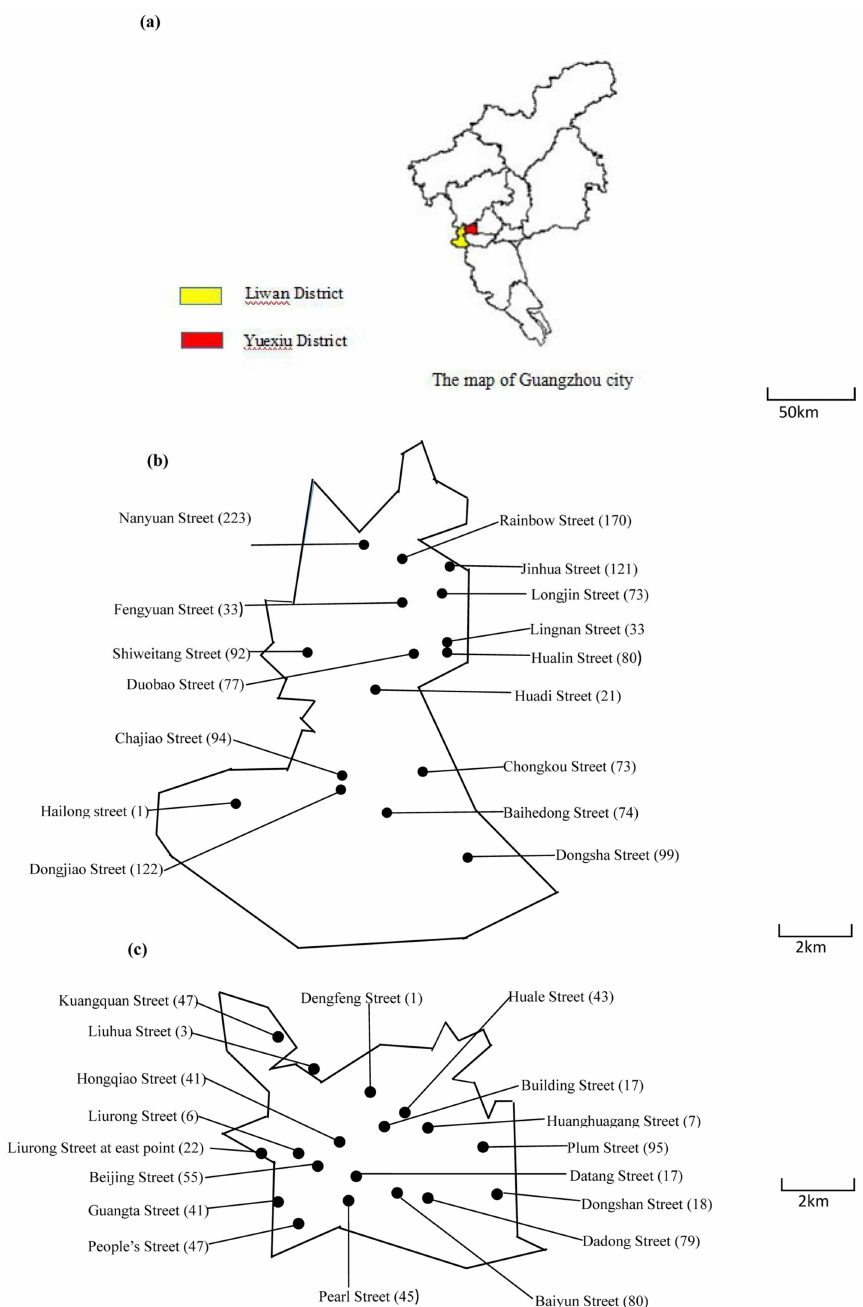
Figure 1. The distribution of residents whose serum samples were collected. The location of community health service centers collecting serum samples from administered residents. Numbers in parentheses indicate how many samples were collected. ( a ), The situation of Liwana District and Yuexiu District. ( b ), The distribution of sampling community health service centers in Liwan District. ( c ), The distribution of sampling community health service centers in Yuexiu